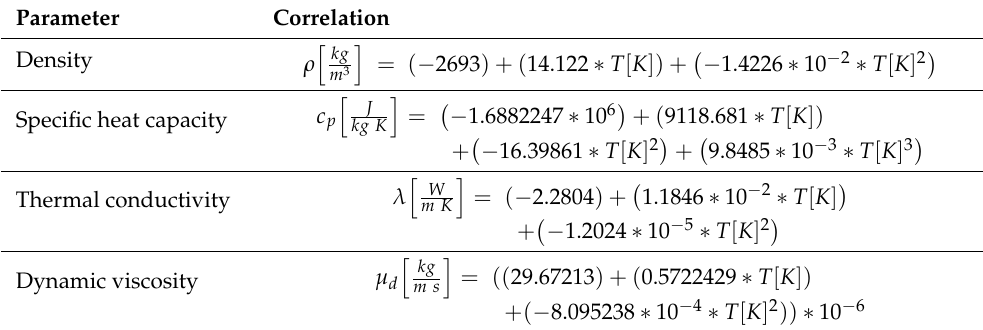
Table 4. Water thermo–physical